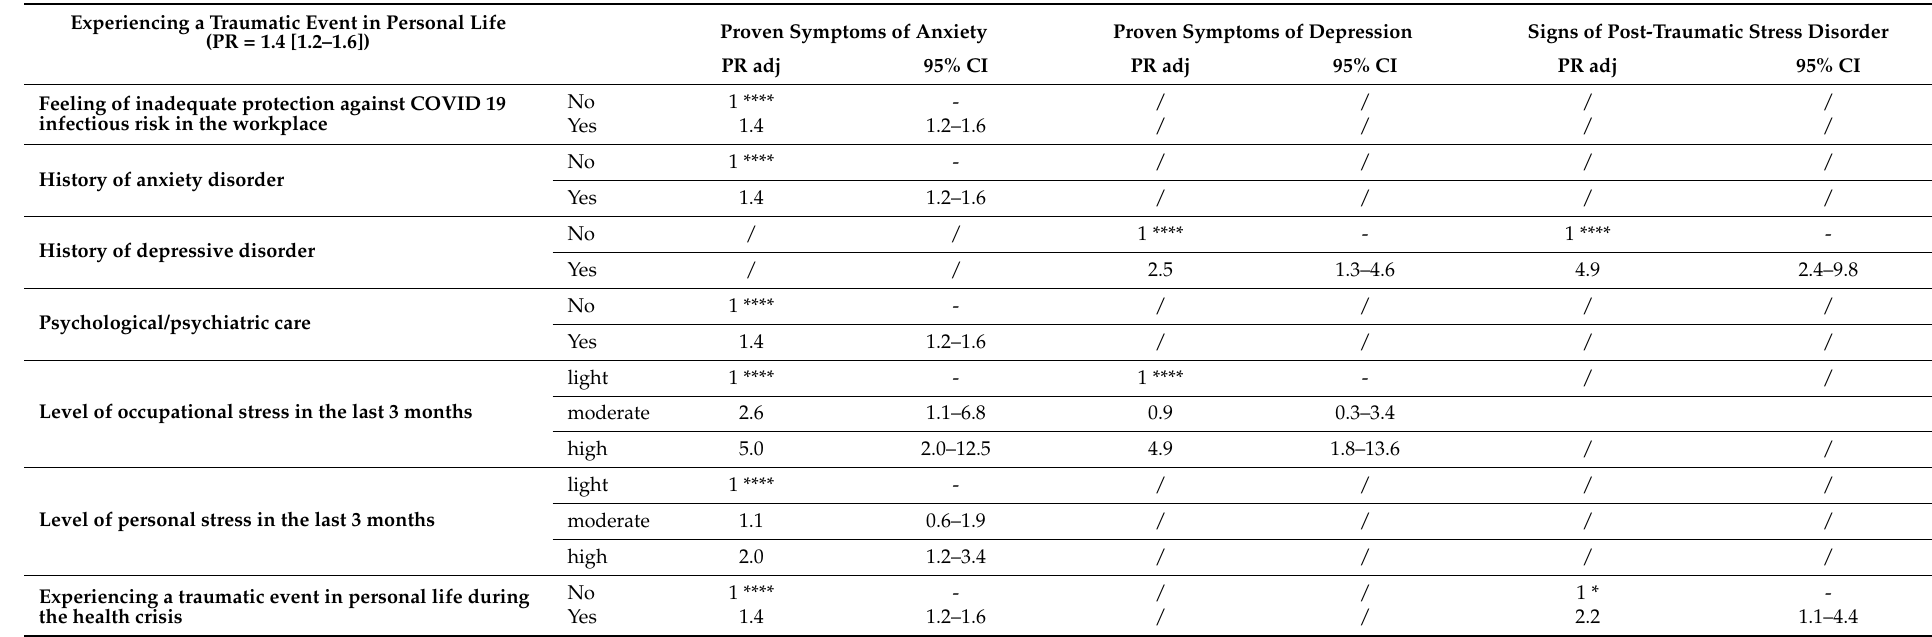
Table 3. Factors associated with anxiety symptoms, depressive symptoms, and Post-Traumatic Stress Disorder after multivariate analysis. Experiencing a Traumatic Event in Personal Life (PR = 1.4 [1.2–1.6]) Proven Symptoms of